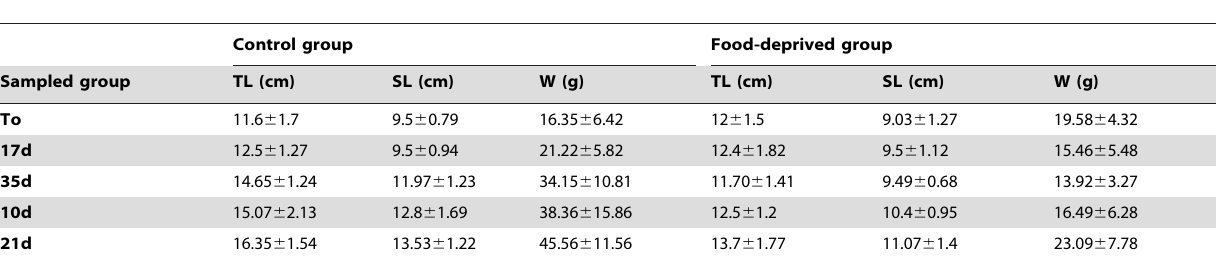
Table 1. Mean of total length (TL), standard length (ST) and Weight (W) for each group of samples animals.